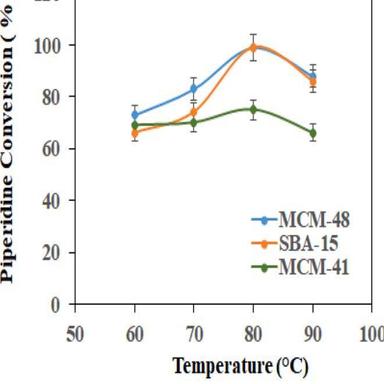
Conversion of piperidine with modified materials, using different amount of catalyst. Reaction condition: Temperature, 80 ◦C; Reaction time, 6 h; Piperidine, 10 mmol; Propylene oxide, 10 mmol.